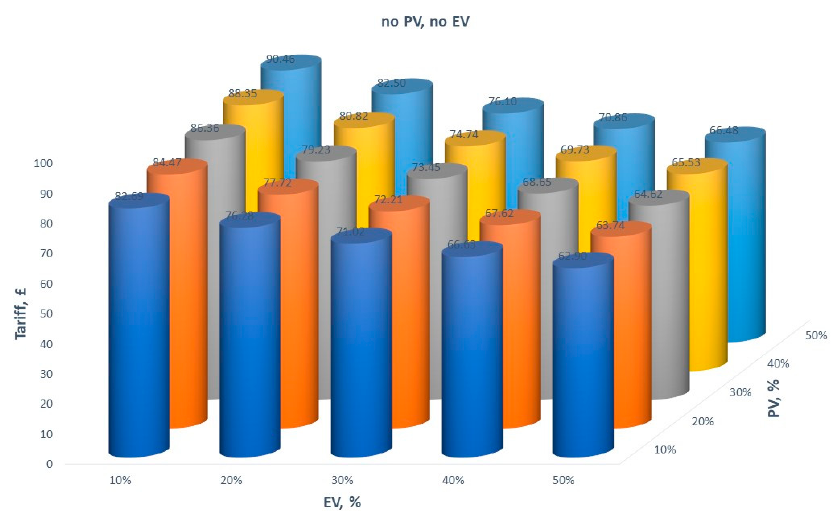
Figure 1. Distribution tariffs for households with no EV and no PV.